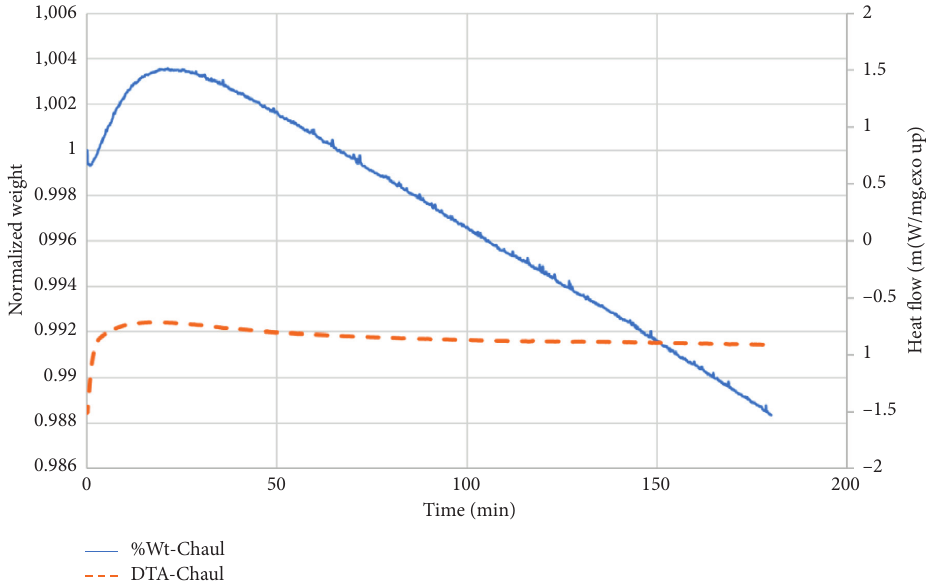
Figure 16: Heat flow, temperature, and normalized weight of chaulmoogra oil obtained from isothermal TGA in oxygen.